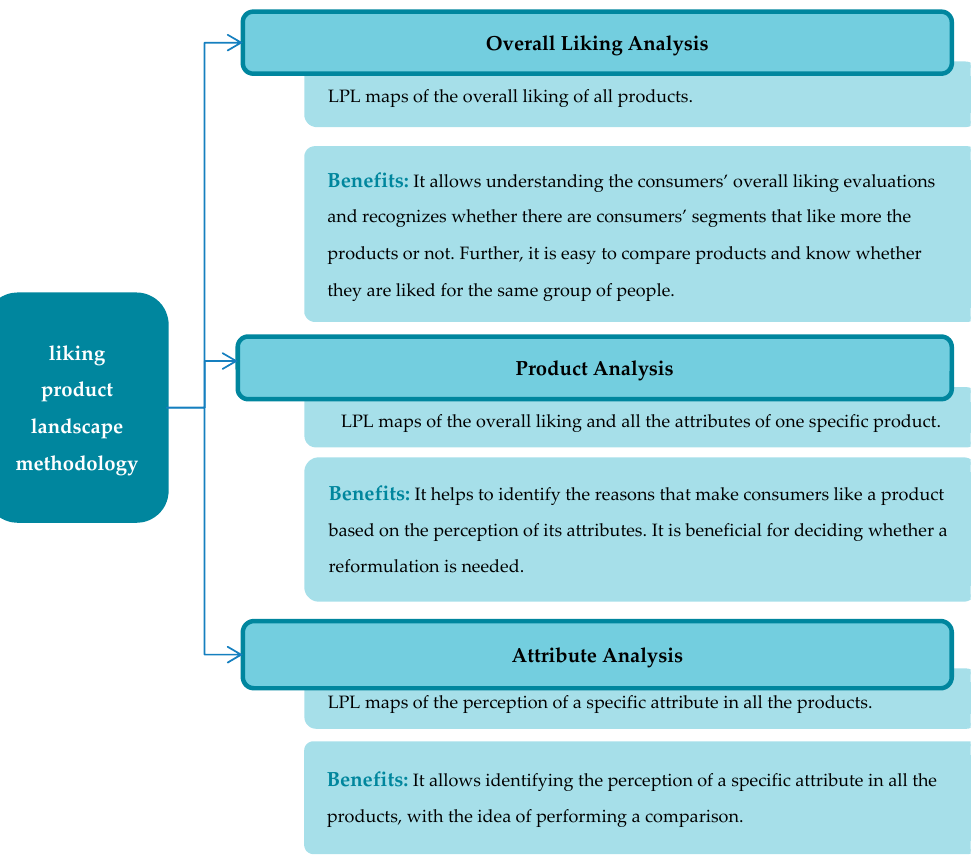
Figure 2. Analysis that can be performed using the liking product landscape methodology.